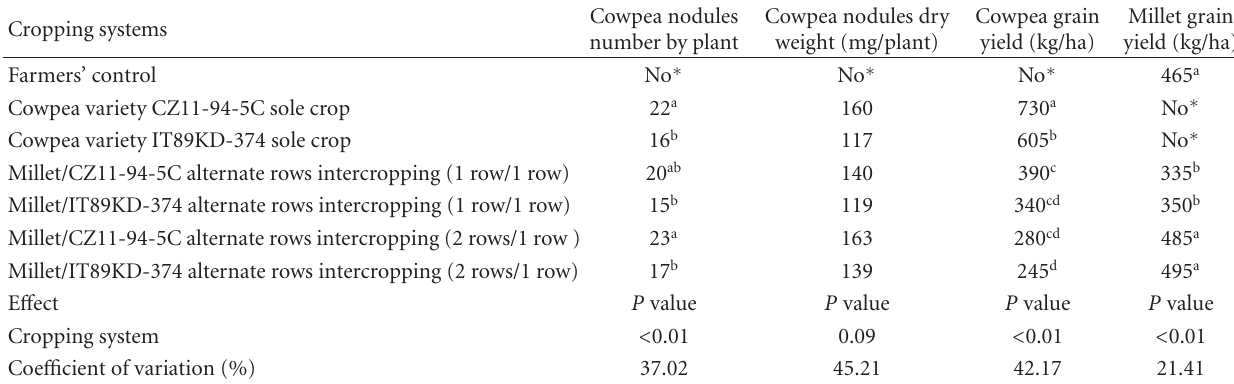
Table 2: Cropping system e ff ects on cowpea nodules number (nodules/plant), nodules dry weight (mg/plant) at bloom stage, and cowpea and millet grain yield (kg/ha) in farmers’ fields in